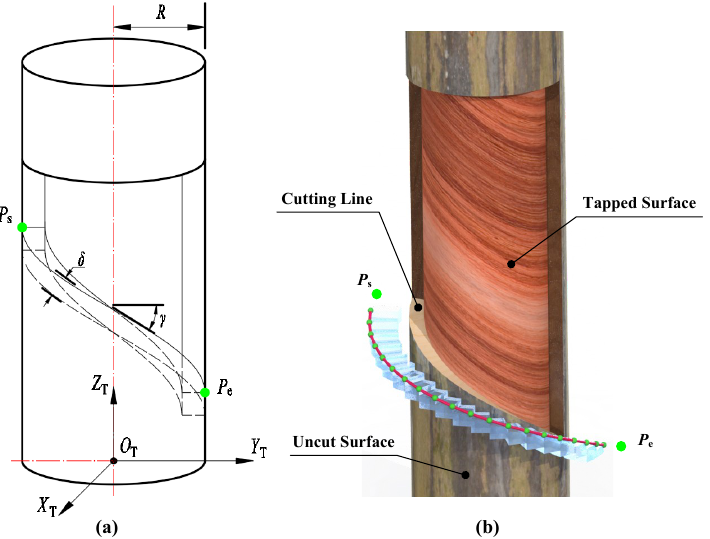
Figure 2. Principles of optimization of the continuous cutting trajectories. ( a ) A simple math- ematical model for the rubber tree trunk. ( b ) Schematic diagram of the cutting trajectory with interpolation points. Table 1. Main parameters of the AUBO